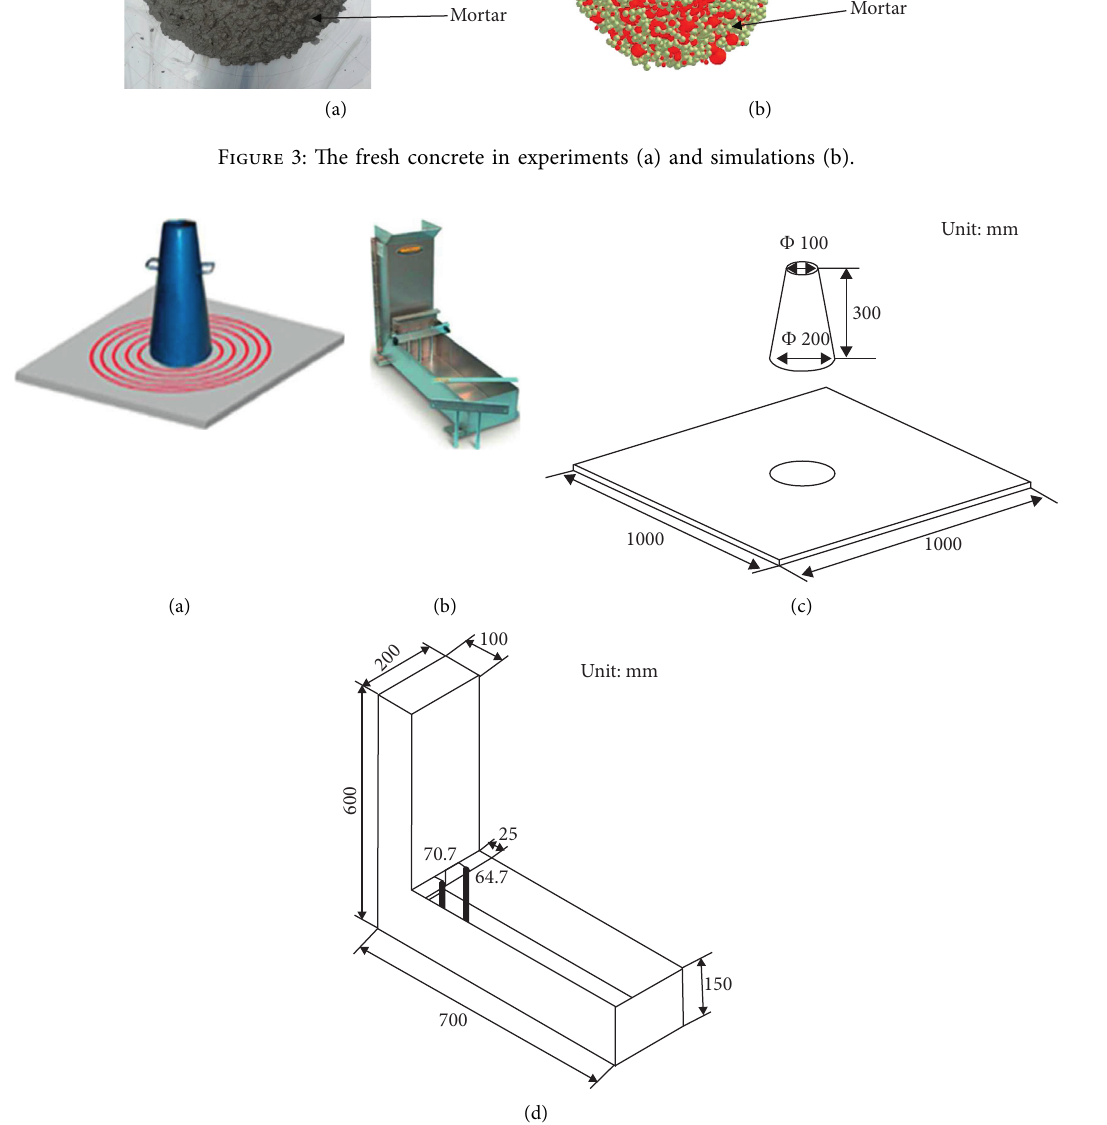
Figure 4: The model of the slump cone (a) and L-box (b); the dimension of the slump cone (c) and L-box